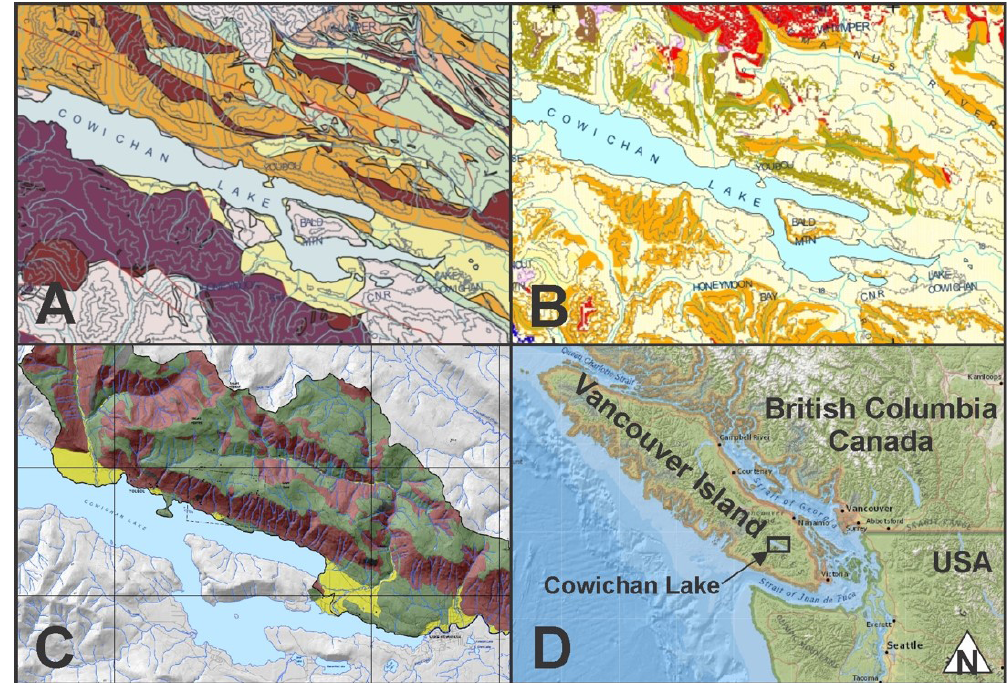
Figure 14. Cowichan Lake on Vancouver Island showing (a) bedrock geology and volcanics of the Sicker Group (orange), Bonanza Group (purple) and Karmutsen Formation (pink); (b) mass movement potential (0.004landslideskm − 2 yr − 1 for the orange zone, up to double that for the tan zone on the north side of the lake); (c) surficial geology (colluvium, till, and fluvial gravels mapped as purple, green, and yellow, respectively); and (d) the overall location. Figure taken from Guthrie (2005a) (a, b) and Palmer (2018) (c) .